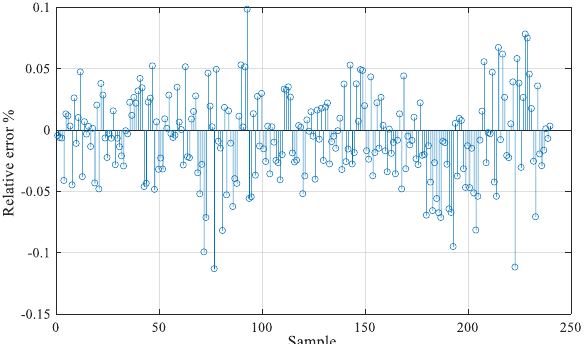
Figure 6. Tidal current speed prediction relative error.